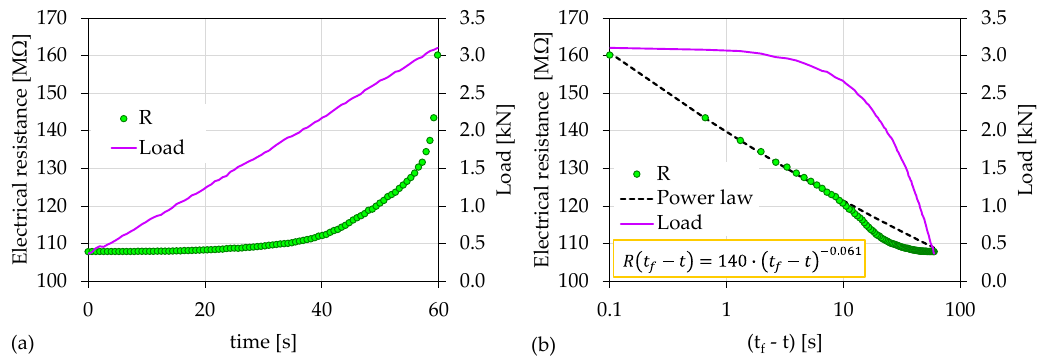
Figure 10. ( a ) The temporal evolution of the electrical resistance ( R ) in juxtaposition to the load applied for the experiment Exp-HR; ( b ) the respective temporal evolution of the recorded electrical resistance ( R ) in terms of the “time-to-failure” parameter. ) − t t parameter is shown in Figure 11. f